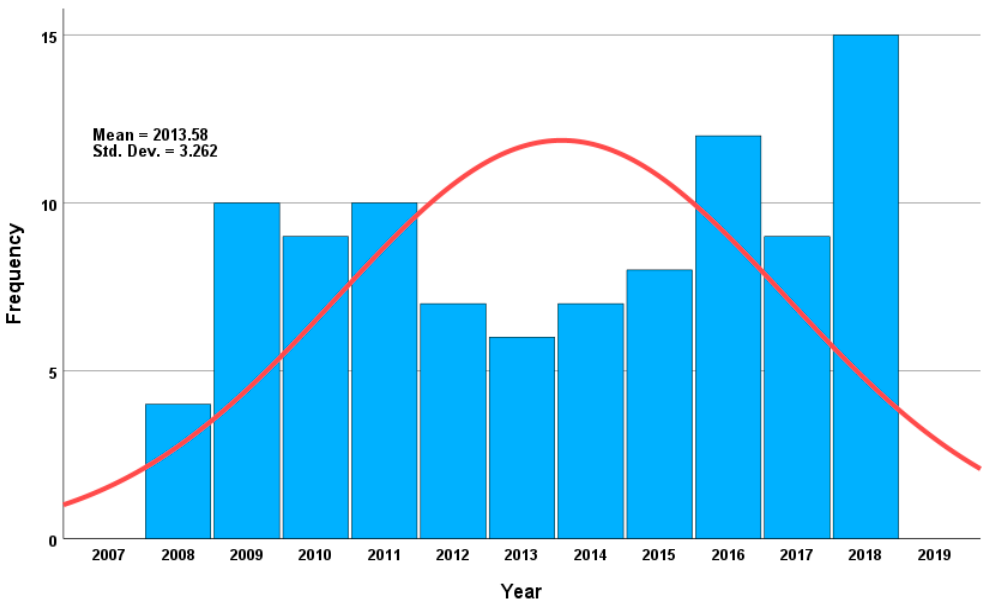
Figure 1. The total number of heroin-related deaths cases over the 10-year period in Jeddah, Saudi Arabia (2008–2018).